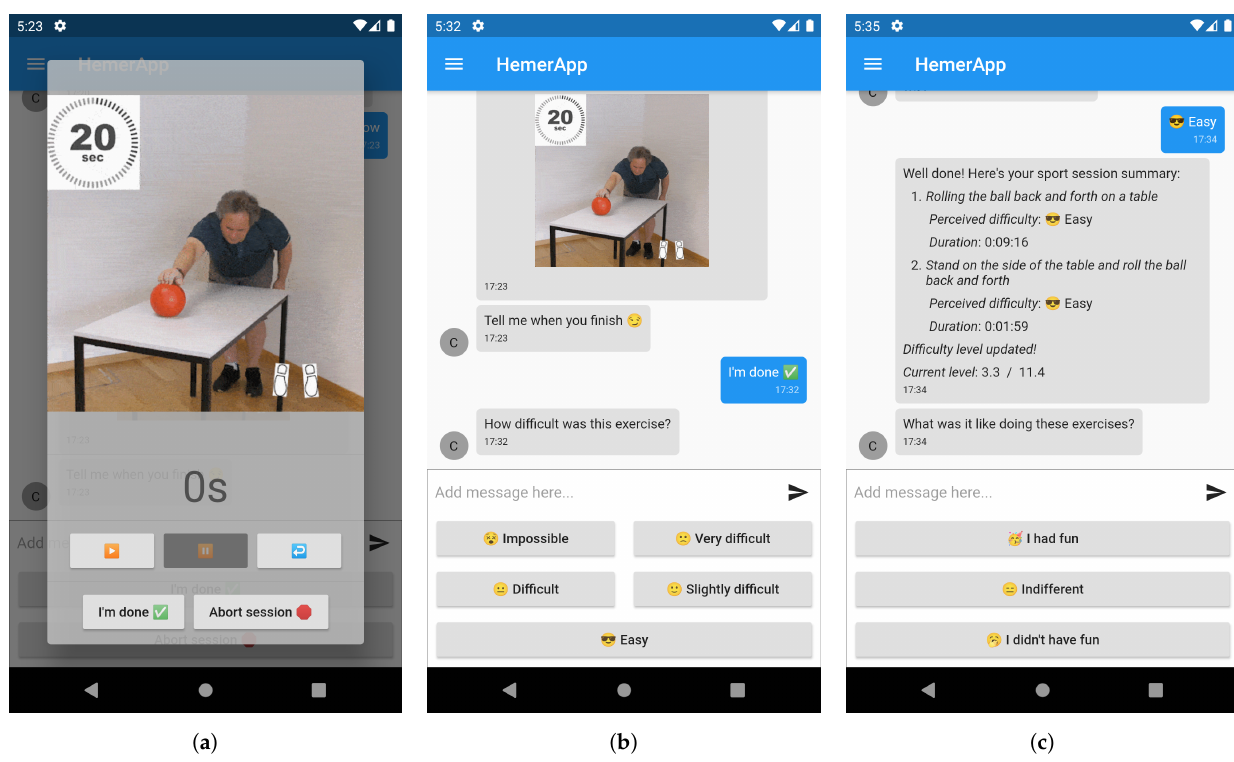
Figure 11. Exercise execution, evaluation, and overall set appreciation in HemerApp. ( a ) Dedicated interface to control the exercises’ execution. ( b ) Rating the difficulty of the exercise just concluded. ( c ) Summary of the exercises and feedback for the overall experience.